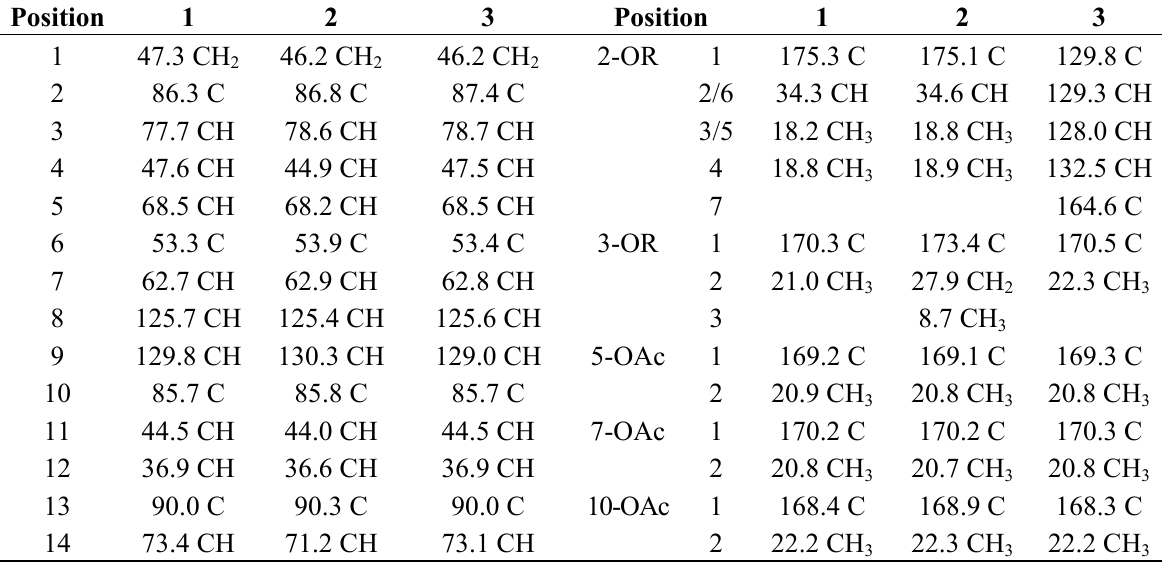
Table 2. 13 C-NMR spectroscopic data for compounds 1  3 (  ppm in CDCl